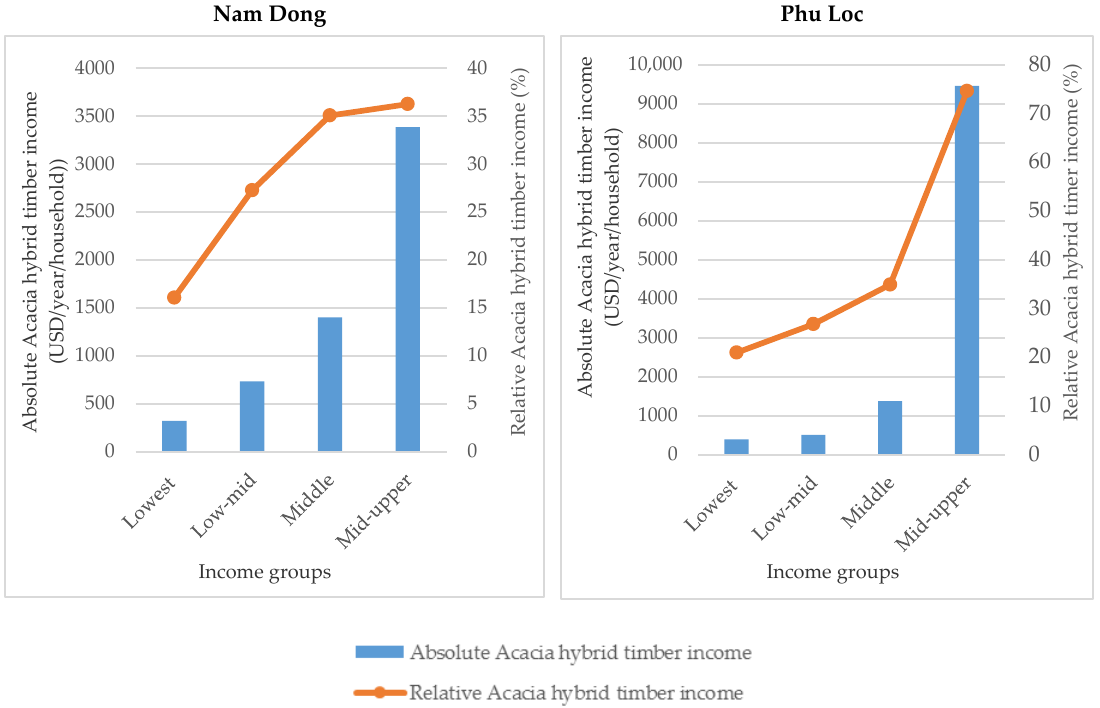
Figure 4. Absolute (USD / year / household) and relative Acacia hybrid timber income by income groups in Nam Dong and Phu Loc district (relative Acacia hybrid timber income by income groups (%) = (average Acacia hybrid timber income in each group / average total income in each group) * 100) (%). Source: Field research (2018, 2019)